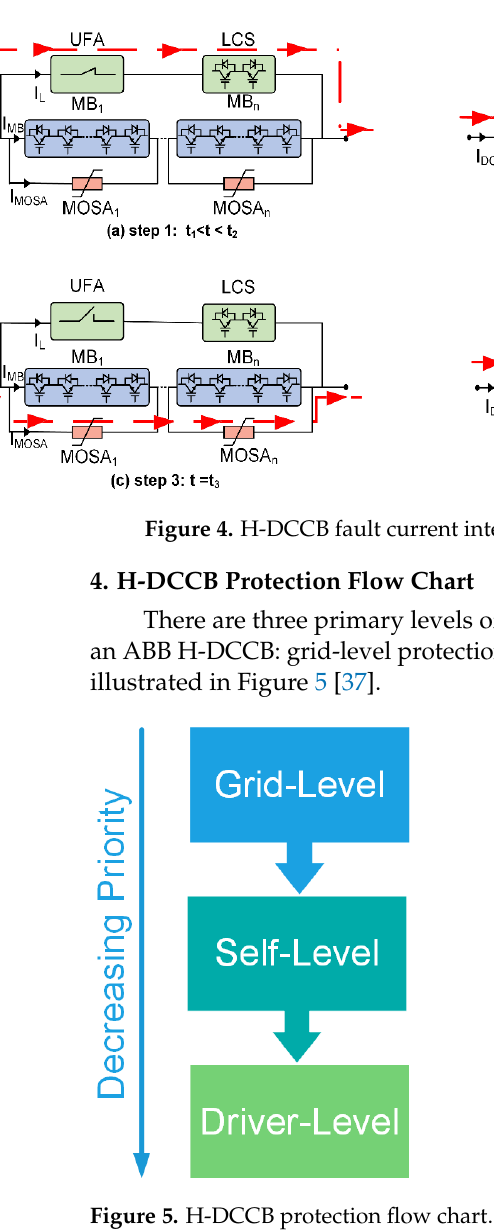
Figure 3. H-DCCB fault current interruption.